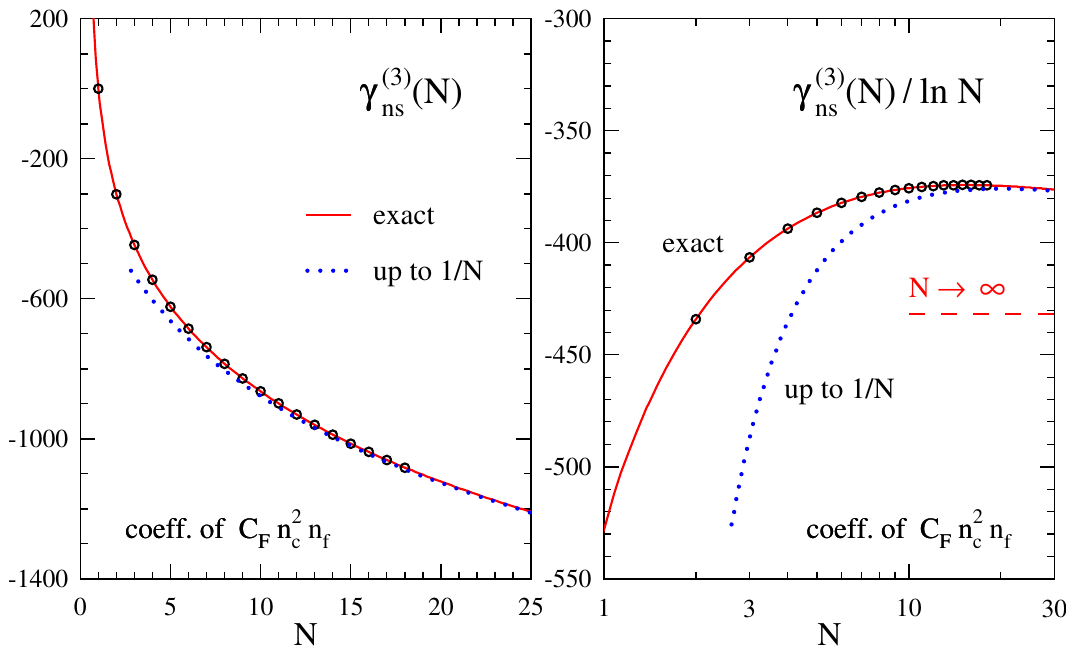
Figure 3 . As (cid:12)gure 2, but for the n 1 contribution (3.7). The value of (cid:13) ( n ) (cid:6) ns ( N ) = ln N in the limit f N is given by the corresponding coe(cid:14)cient of A L; 4 in the second line of eq. (3.8). ! 1